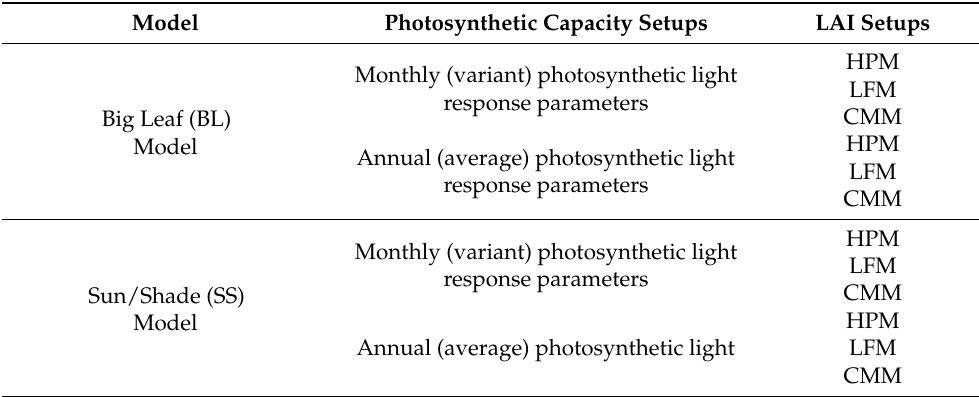
Table 2. Overview of the six different model setups. See Equation (1) for description of the light response model parameters. Leaf Area Index (LAI) estimated using the following: